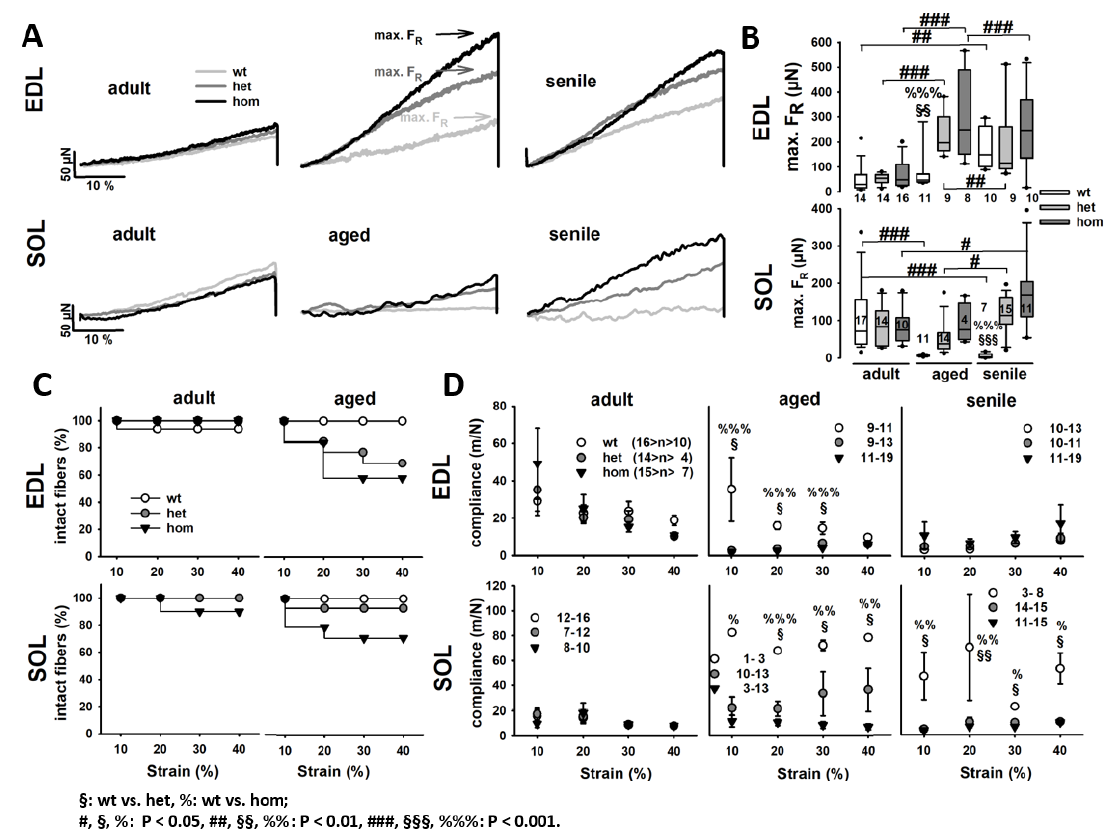
Figure 3. Passive steady-state RLT curves of single EDL and SOL fiber segments from adult, aged, and senile mice carrying the R349P desmin mutation. ( A ) Representative force recordings in single EDL (top) and SOL (bottom) fibers for each genotype and age cohort investigated. During aging, het and hom R349P desmin knock-in fibers present with a markedly steeper curve and increased maximum restoration forces. This was confirmed in the group analysis in ( B ), showing a significantly increased restoration force in both het and hom fibers, already in the aged mice. Force values in wt fibers remained reduced, but eventually increased within the senile age group. ( C ) Kaplan–Meier survival plots, shown for the adult and aged group, depict a much lower survival of mutant single fibers during the stretch protocol compared to wt fibers. ( D ) Axial compliance derived from slopes to the RLT curves to each section of 10% stretch decreases with stretch. Mutant fibers generally show lower compliance values than wt fibers, except for adult mice in both EDL and SOL, and senile mice in EDL. Significance tested with two-way ANOVA followed by post hoc analysis (Bonferroni). Numbers in box plots: number of single fibers